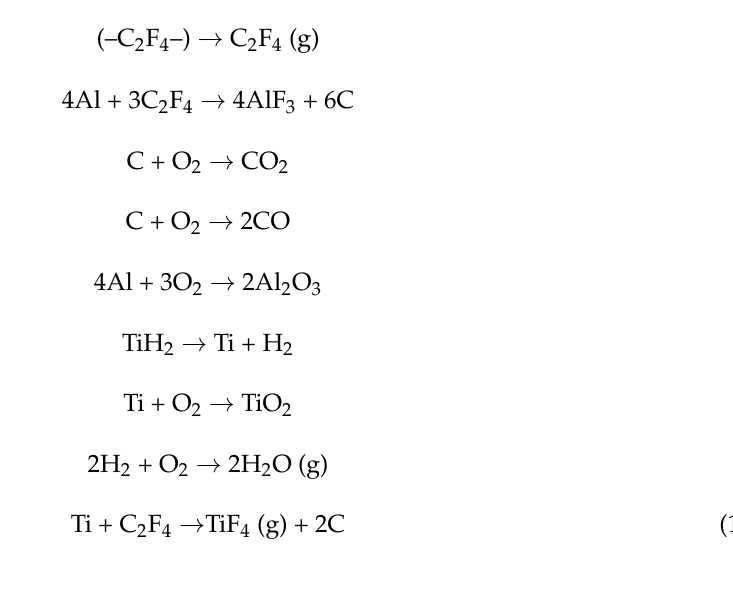
Table 2. Reaction energy of the PTFE/Al/TiH 2 composites in an oxygen